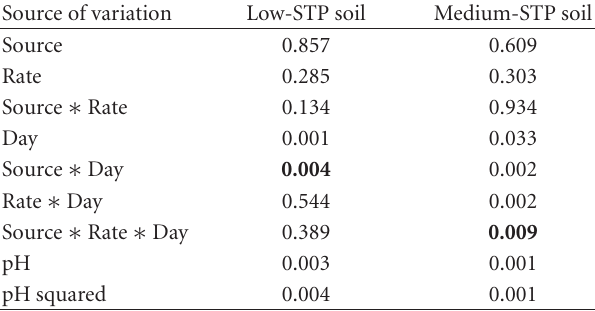
Table 5: ANOVA P- values that show the main and interaction e ff ects of Source of P (Source), Rate of application (Rate), and Incu- bation time (Day) as well as the linear and quadratic coe ffi cients of the covariate on %PRR. Significant e ff ects that require further multiple means comparison are shown in